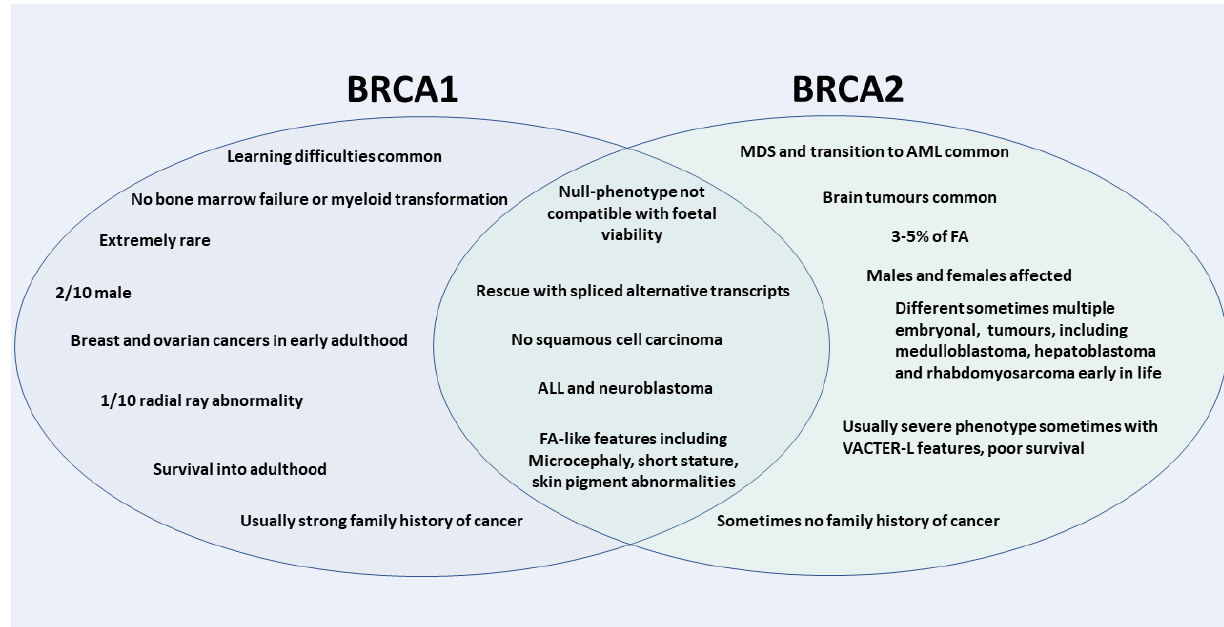
Figure 1. Common and diverse clinical and cellular aspects of bi-allelic pathogenic variants in BRCA1 and BRCA2 .